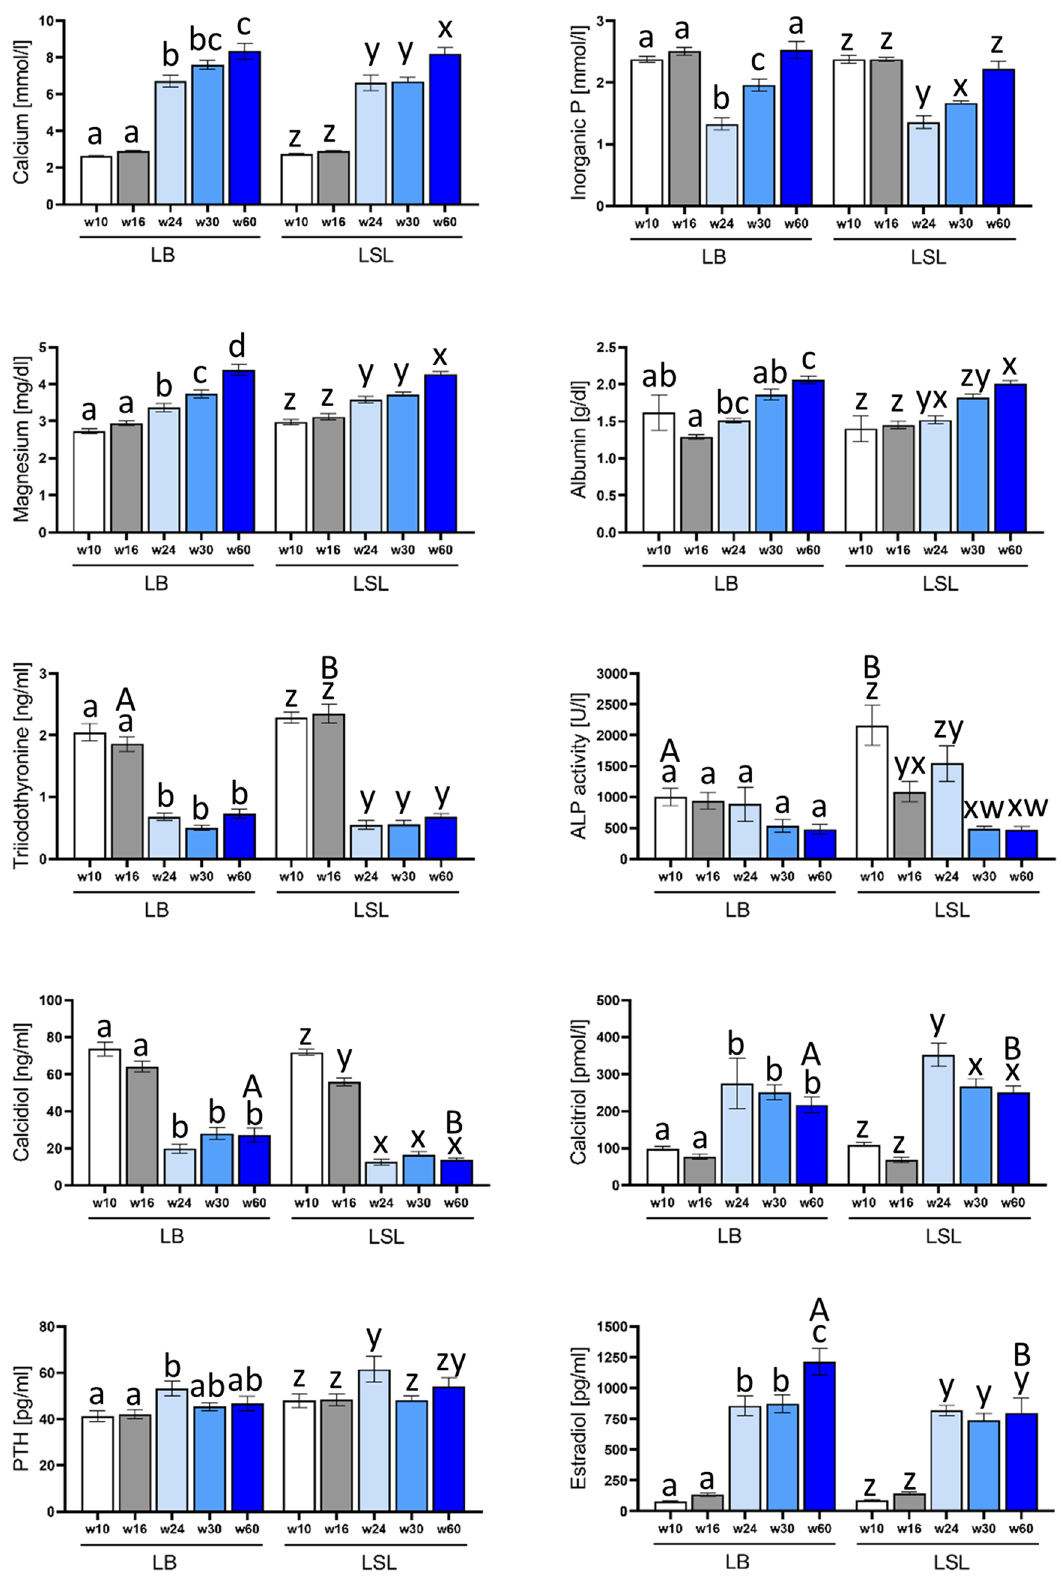
Figure 1. Plasma parameters referring to endogenous mechanisms to maintain mineral homeostasis with respect to the selected production stages (weeks 10, 16, 24, 30 and 60) of the LB and LSL laying hens. Values are displayed as means ± SE. Data for inorganic P and calcium were adopted from 9 . Superscripts indicate statistical significance ( P < 0.05) between laying hen strains (capital letters) and production stages (small letters). PTH— parathyroid hormone; ALP—Alkaline